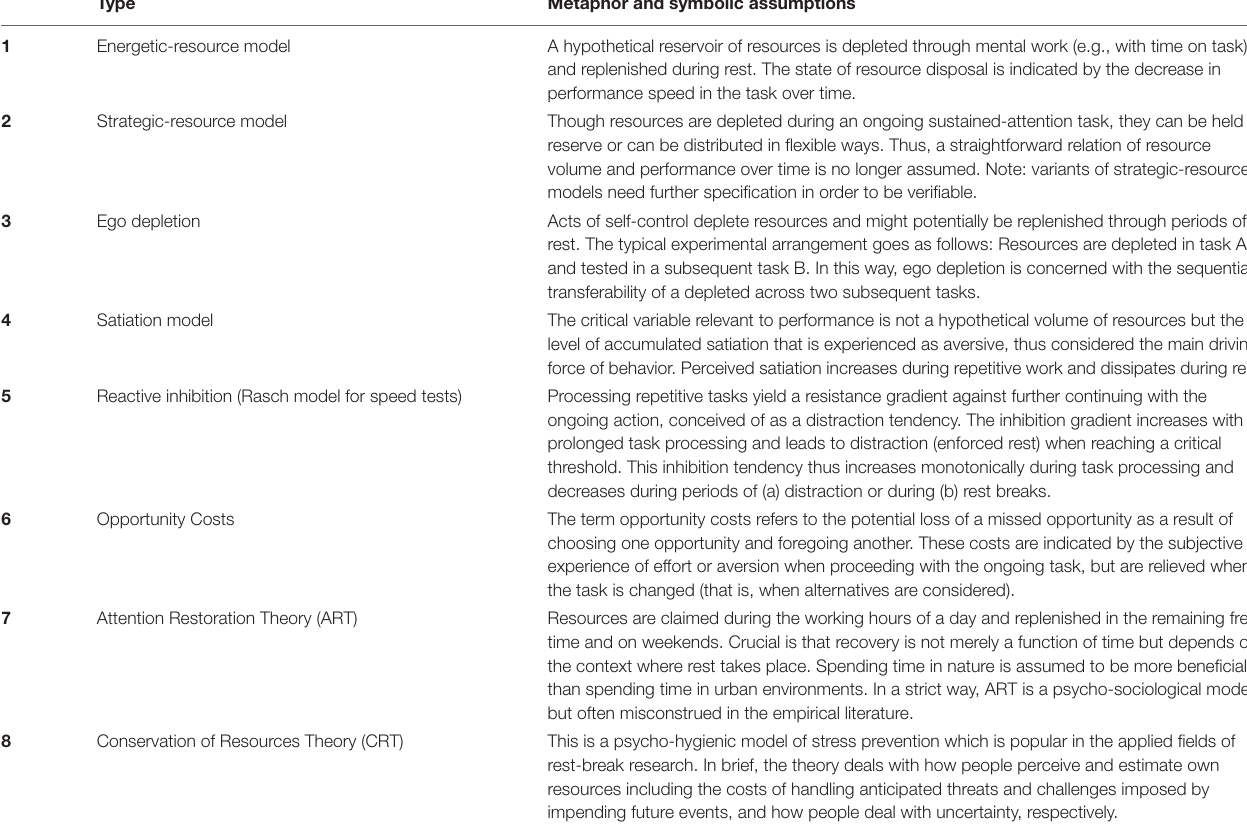
TABLE 2 | Popular metaphors typically guiding theoretical predictions in the rest-break literature. Type Metaphor and symbolic